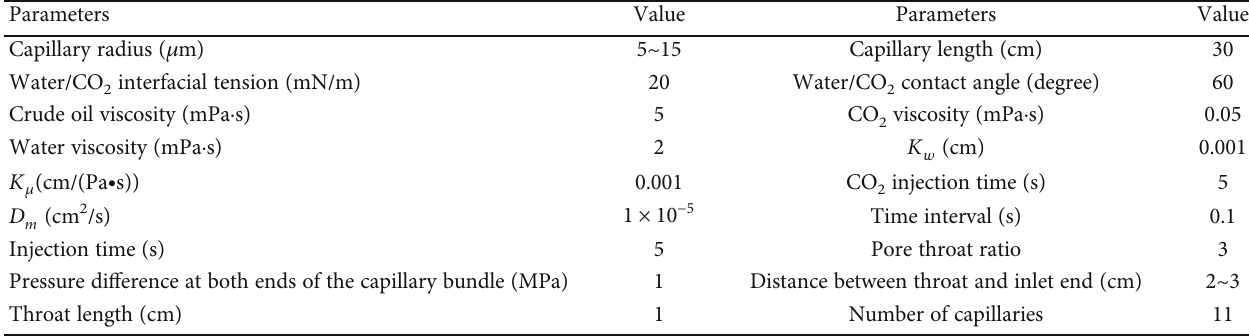
water-alternating-gas 2